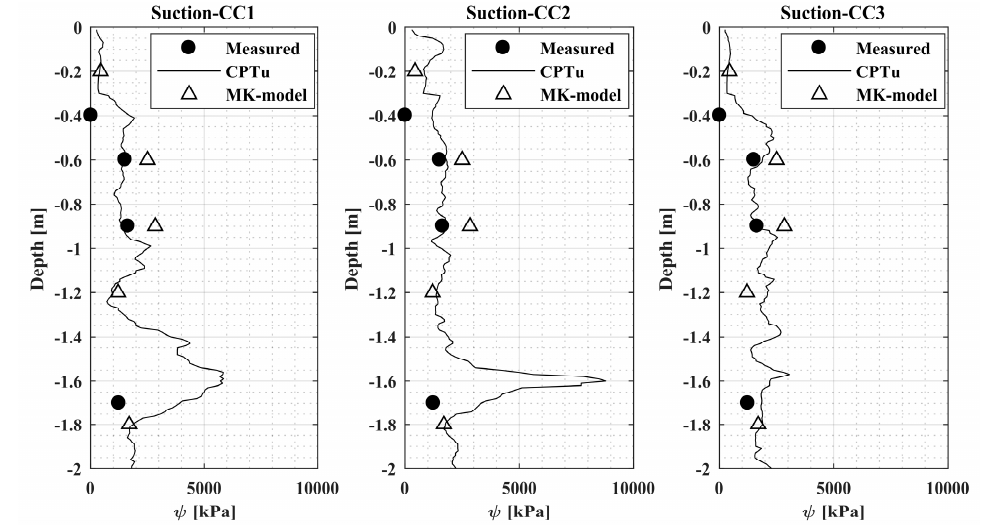
Figure 7. Measured and estimated values of suction at CC site.